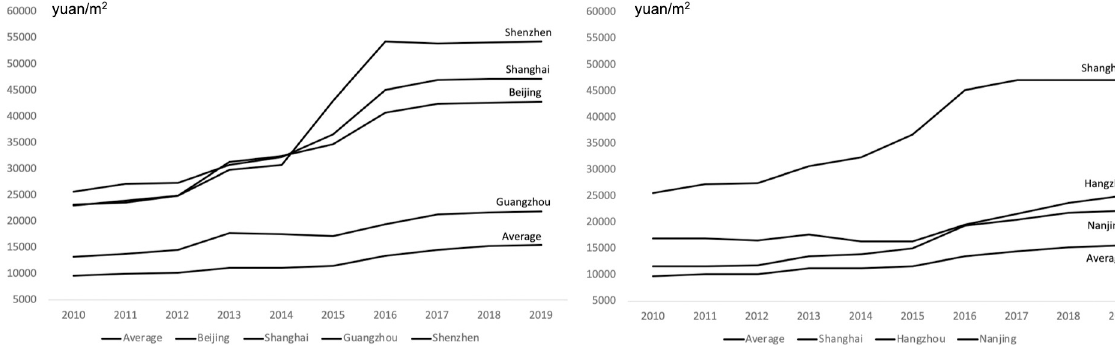
Fig 1. Average housing prices and housing prices in major cities.